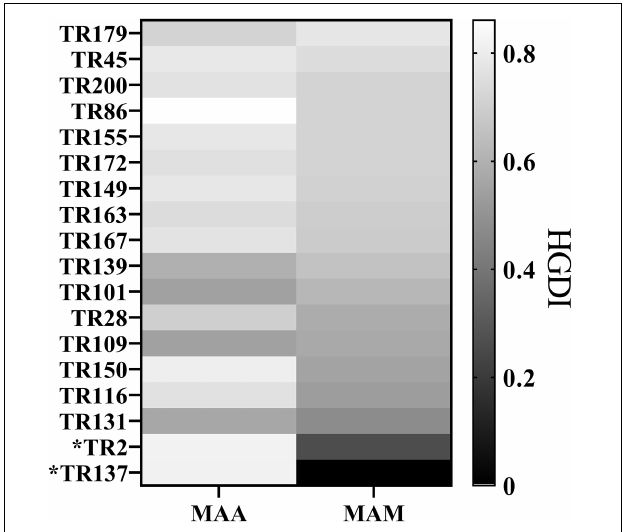
FIGURE 2 | Hunter–Gaston Discriminatory Index (HGDI) for each variable number tandem repeat (VNTR) locus stratified to different subspecies showing that the TR137 and TR2 loci exhibited the potential to distinguish subspecies within Mycobacterium abscessus complex (MABC).